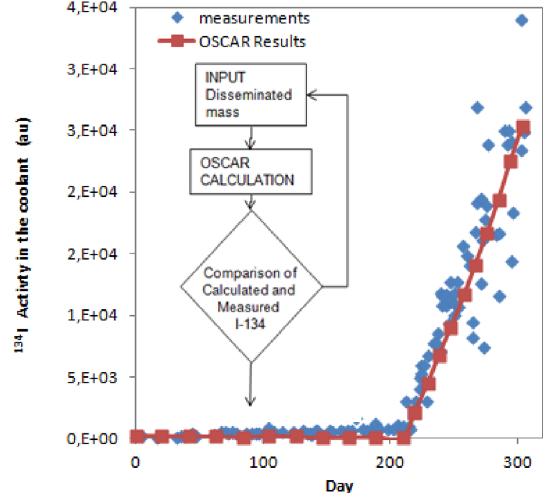
Fig. 7. Comparison of plant measurement and OSCAR calcula- tion of 134 I variation in a case of fi ssile material